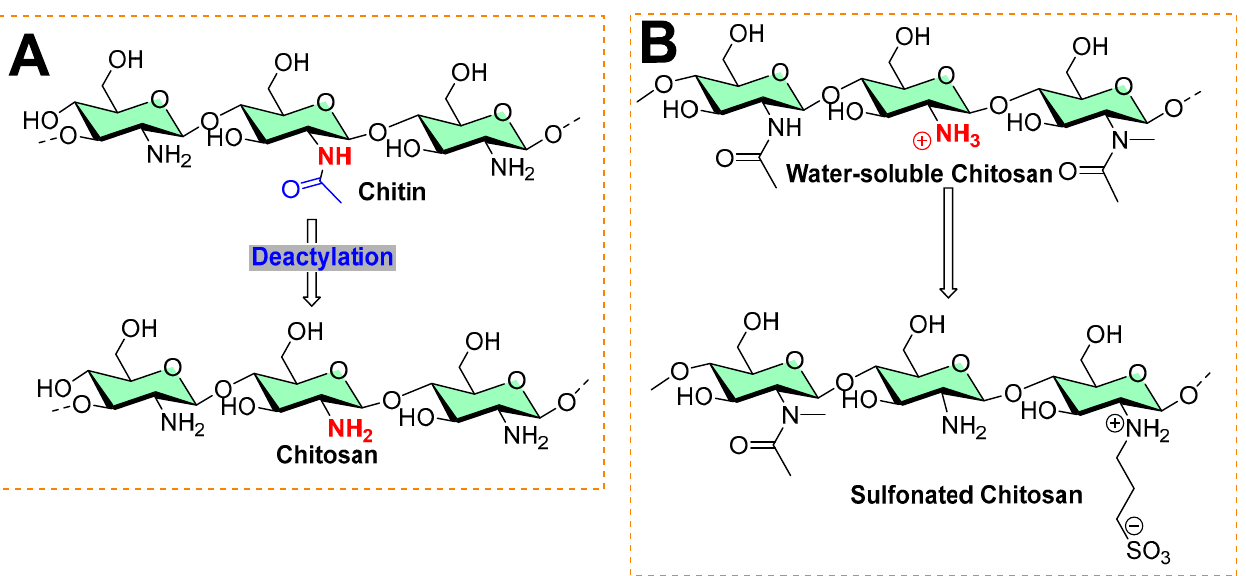
Figure 8. Typical processes in chitosan chemistry: ( A ) commercial preparation from chitin by deacetylation is found in the exoskeleton of crustaceans and the cell wall of fungi. ( B ) Sulfonation of